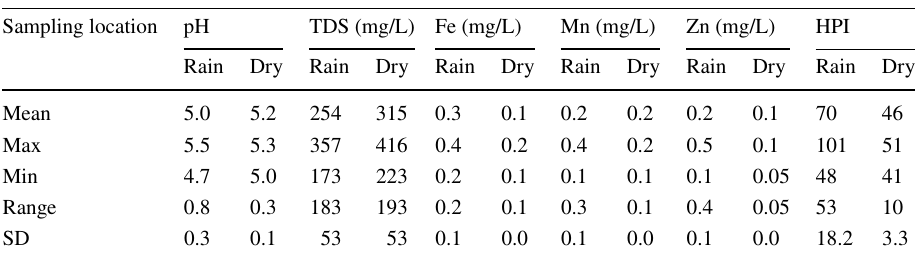
Table 3 Descriptive statistics of the metal concentrations in the water samples